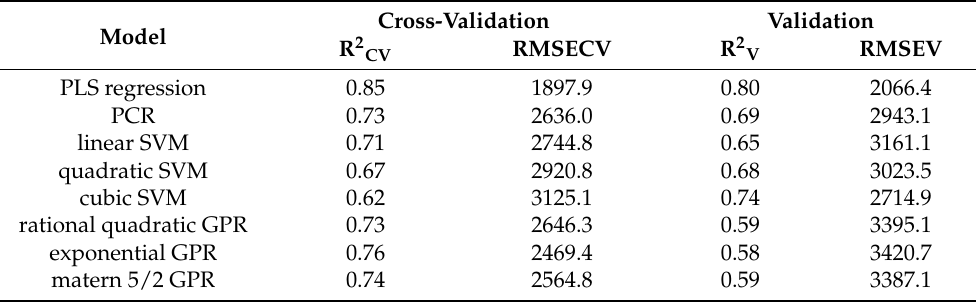
Table 4. Different regression models with coefficients of determination (R²) and root mean square error (RMSE) of the regression and validation using the field samples from Poland measured on the Echelle spectrometer after the elimination of outliers by the ROBPCA method.